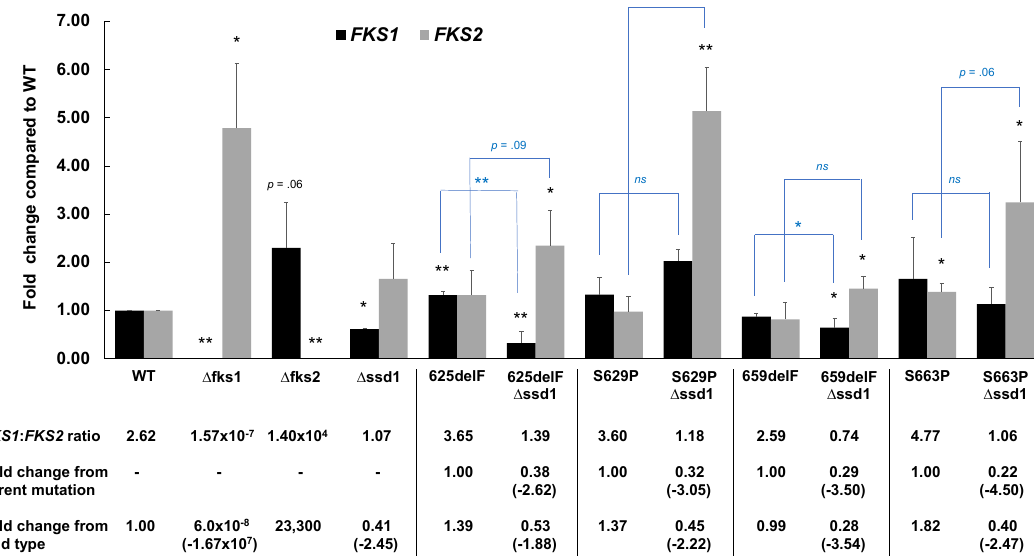
Figure 2. SSD1 deletion leads to general decreases in FKS1 gene expression and increases in FKS2 gene expression. RNA was isolated from cells harvested at mid-log phase and expression compared to that of the wild type cells (2 − ∆∆ Ct ). Expression was normalized to RDN5.8 . Mean plus SD of 3 independent experiments is shown. * p < 0.05, ** p < 0.01, ns = not significant; Student’s t -test, two-tailed. p values in black compare expression to wild type while brackets and p values in blue compare the same FKS mutant with and without SSD1 . Relative expression ratios of FKS1 to FKS2 are displayed below the figure with associated fold changes from wild type or parental mutant.